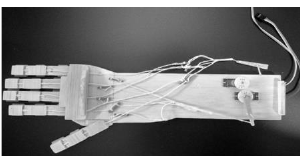
Fig. 6. Arm/hand model used in the project